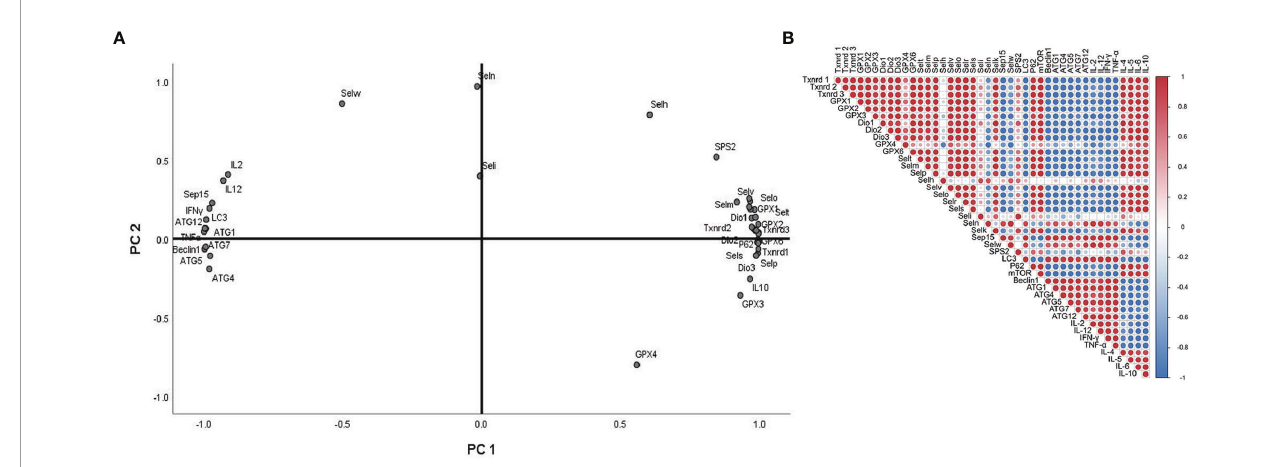
FIGURE 8 | Principal component analysis (PCA) and correlation analysis of autophagy-related genes, related Th1/Th2 cytokines, and selenoprotein mRNA expressions with 0-, 25-, 50-, and 100- m M Sch B treatment in Hepa1-6